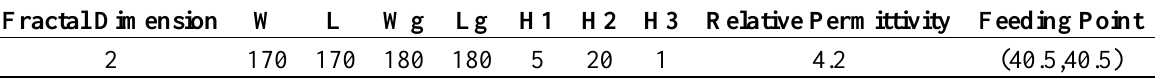
Table 1. Dimensions of the microstrip antenna (in